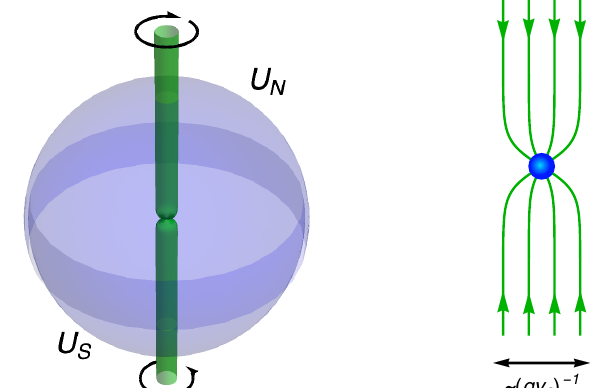
Figure 2 . Left : a schematic figure of the bead configuration. A string and an anti-string are attached to the monopole placed at the center of the sphere. The arrows show the directions of the circular currents inside the strings. Right : the magnetic flux of U(1)